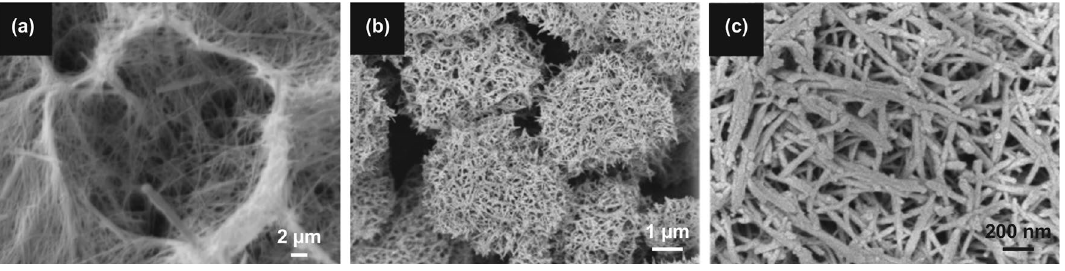
S with 3 2 Co S was then synthesized 1.4 1.6 2 S as a template. 3 2